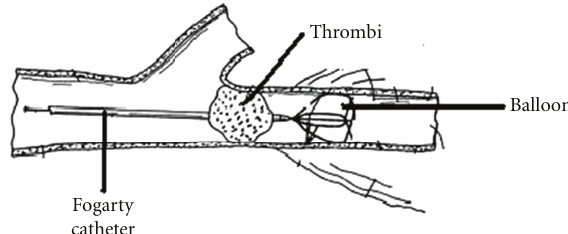
Figure 1: The embolectomy technique with Fogarty catheter.